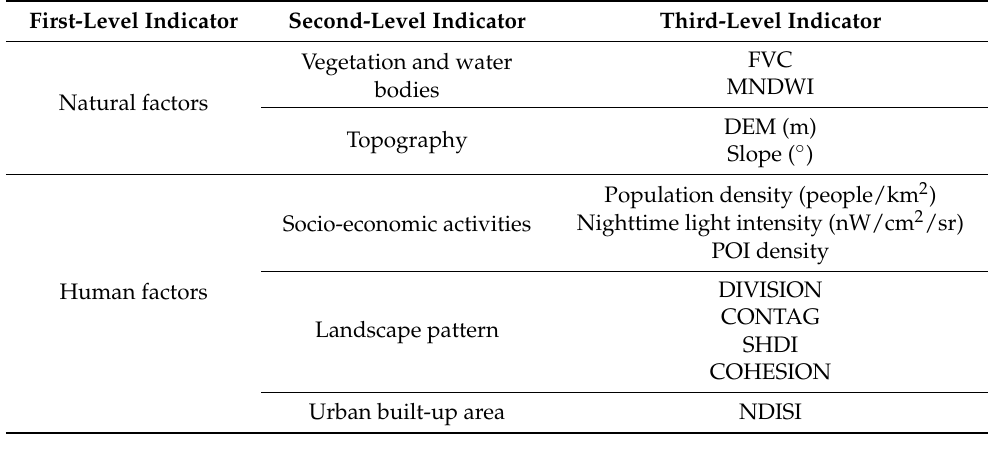
Table 2. Indicators of associated factors of Chongqing’s urban thermal